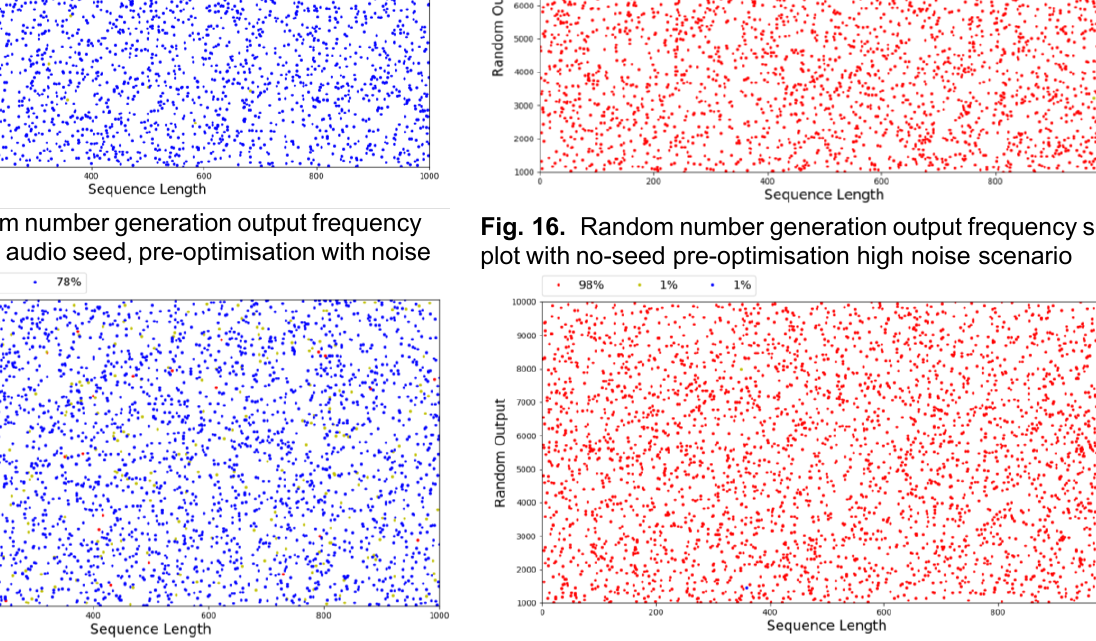
Fig. 17. Random number generation output frequency scatter plot with no-seed pre-optimisation low noise